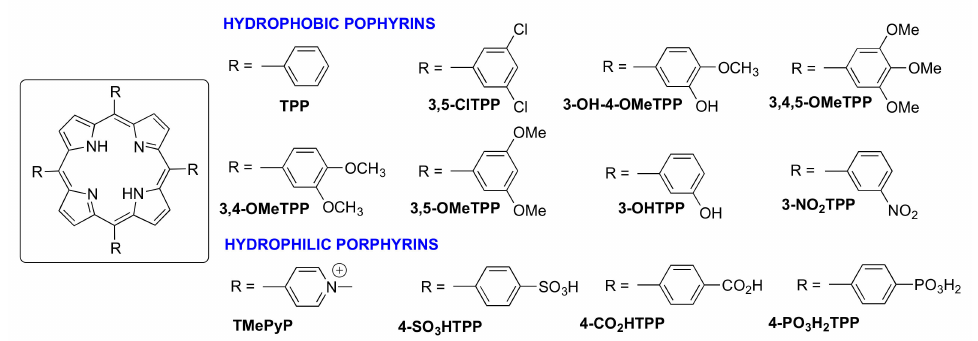
Chart 1. Porphyrins and acronyms used in this